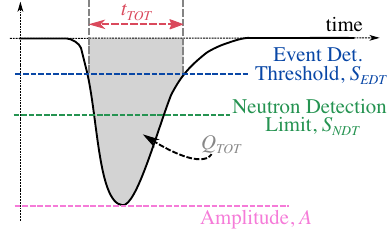
FIG. 5. Sketch of a neutron event with NDA settings and some of the pulse